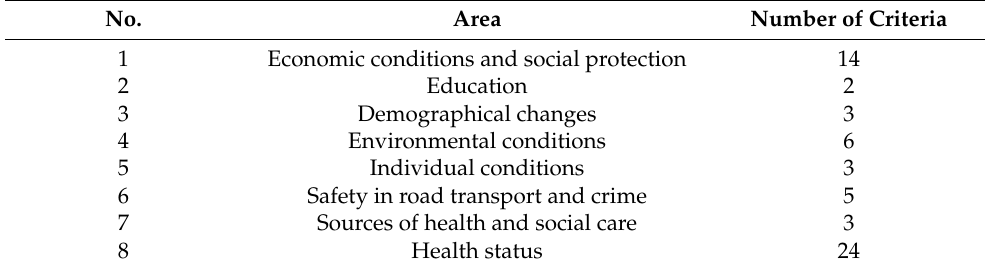
Table A1. Basic description of compared